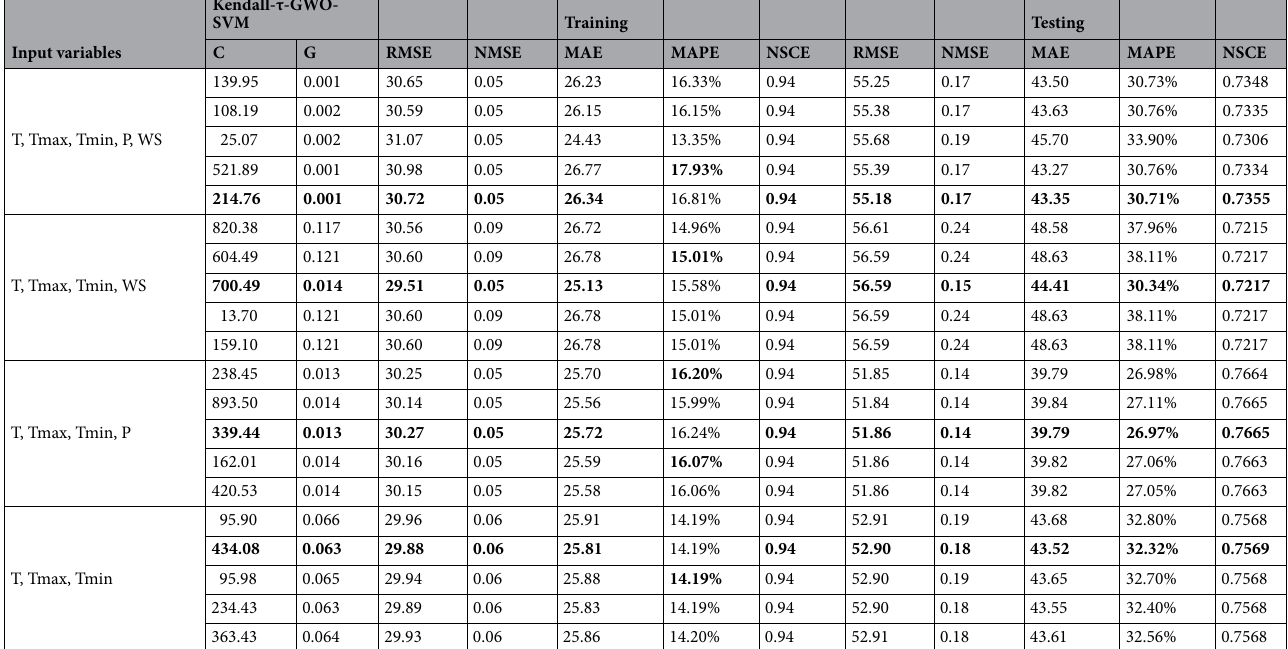
Table 5. The optimal hyper-parameters and model performance of Kendall-τ-GWO-SVM. The optimal hyper-parameters and evaluation metrics of the hybrid Kendall-τ-GWO-SVM model are marked in